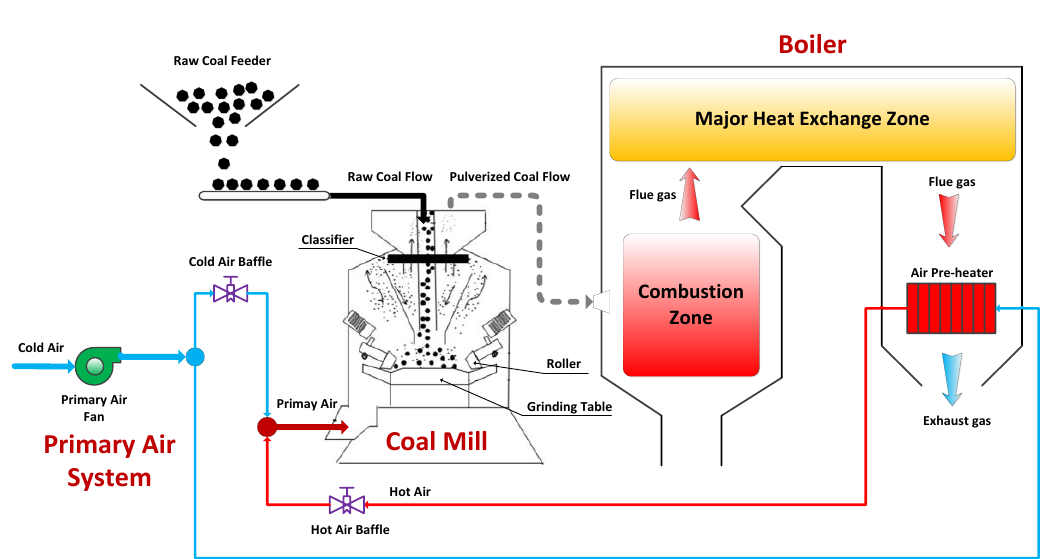
Figure 1. Simplified diagram of a typical pulverizing system.